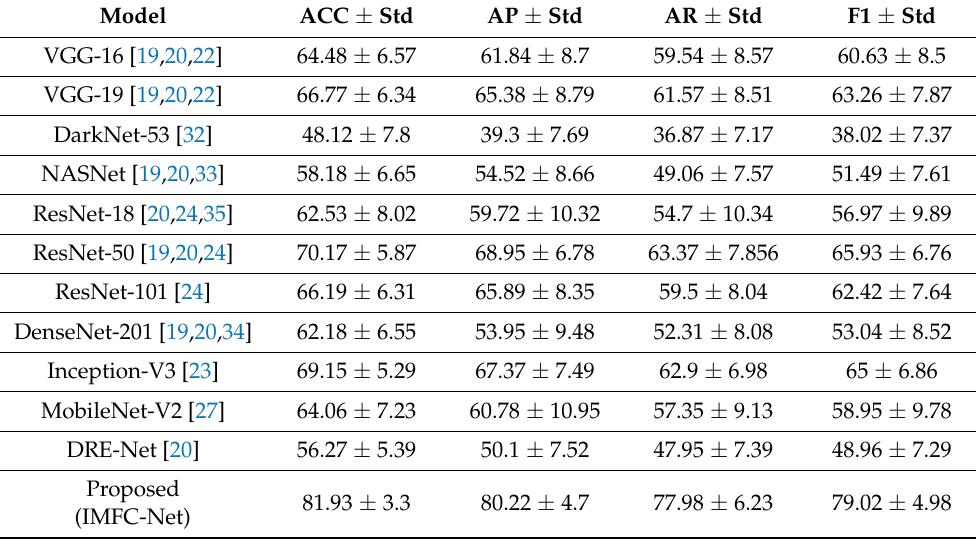
Table 6. Comparative performance analysis of the average results of ten-fold cross-validation between the state-of-the-art and proposed models without using augmentation for the shoulder implant dataset [18,19]. (ACC: accuracy, AP: average precision, AR: average recall, F1: F1.score, Std: standard deviation, unit: